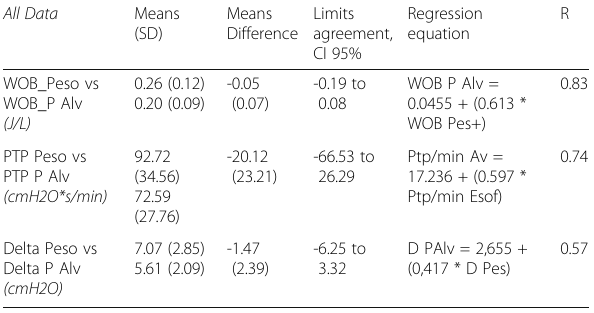
Table 1 (abstract 000856). Agreement of the measurements between both